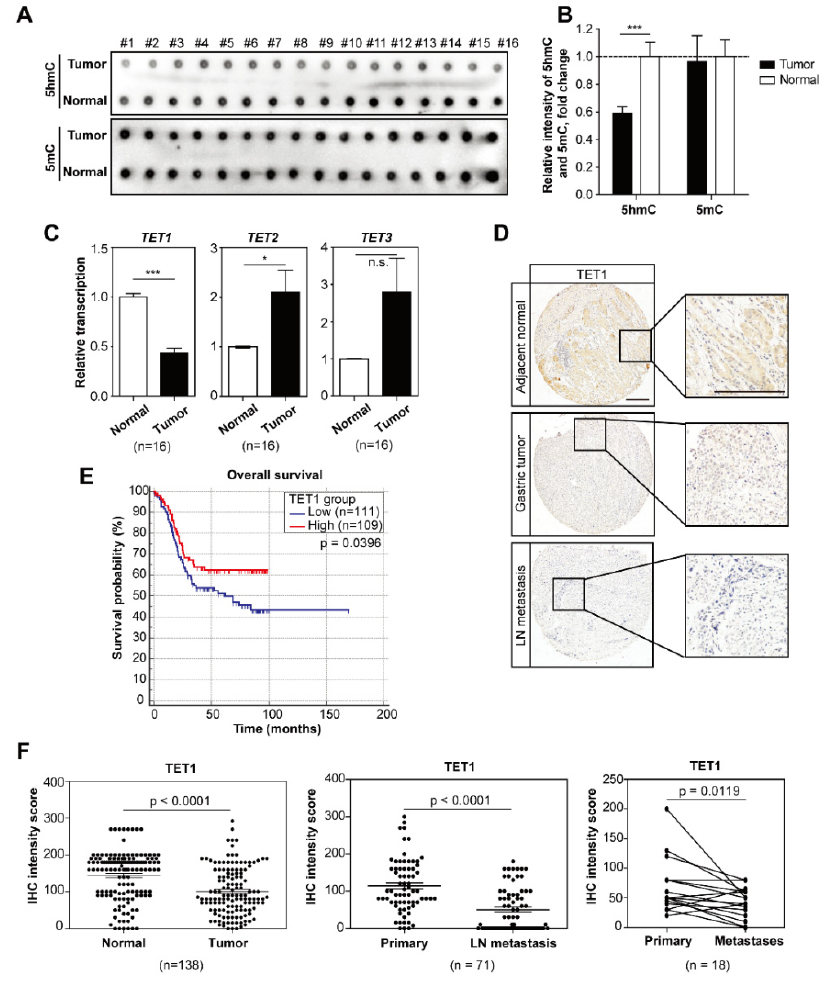
Figure 1. The DNA methylcytosine dioxygenase TET1 is low in metastatic gastric tumors and predicts poor survival of patients. ( A ) Dot blot analysis of global 5hmC and 5mC levels in paired tumor biopsies and adjacent normal tissues from patients with metastatic gastric cancer. ( B ) Quantification of relative 5hmC and 5mC levels in ( A ). ( C ) qRT-PCR analysis of TET1, TET2 and TET3 transcripts comparing paired tumors vs. normal tissue samples as in ( A ). ( D ) Representative pictures of TET1 IHC staining in normal tissue, primary tumors and lymph node metastases of gastric cancer patients. Scale bars represent 100 µm. ( E ) Kaplan–Meier analysis showing overall survival of gastric cancer patients with high vs. low TET1 expression. Median value of TET1 IHC intensities is used as cut-off to separate low and high groups. ( F ) IHC staining intensities comparing TET1 expression in normal tissue samples vs. paired primary tumors ( left ), primary tumors vs. paired lymph node metastases ( middle ), and primary tumors vs. paired distant metastases ( right ). Error bars indicate mean ± SD. ***, p < 0.001. *, p < 0.05. n.s., not significant.